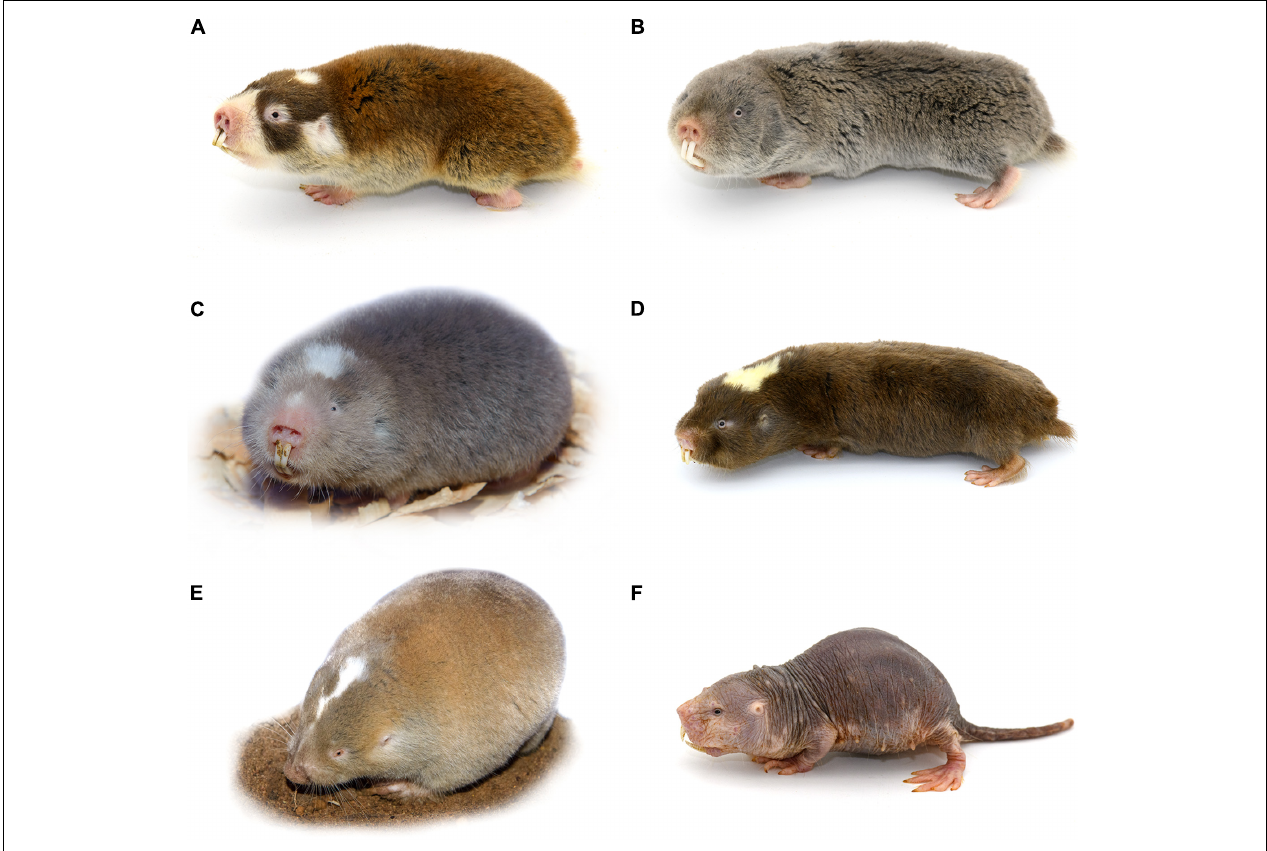
FIGURE 1 | Images of a representative animal of each of the six genera of the family Bathyergidae. (A) Georychus capensis ; (B) Cryptomys hottentotus pretoriae ; (C) Heliophobius emeni ; (D) Fukomys damarensis ; (E) Bathyergus suillus ; (F) Heterocephalus glaber . Panels (A,C,E) are solitary species, while panels (B,D,F) represent social